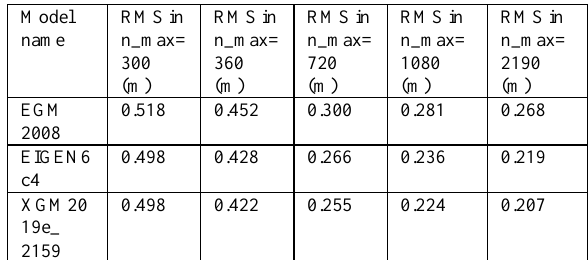
Table 3 . RMS of geoid heights of 841 GPS/Leveling points calculated for most used combined geopotential models expanded to different